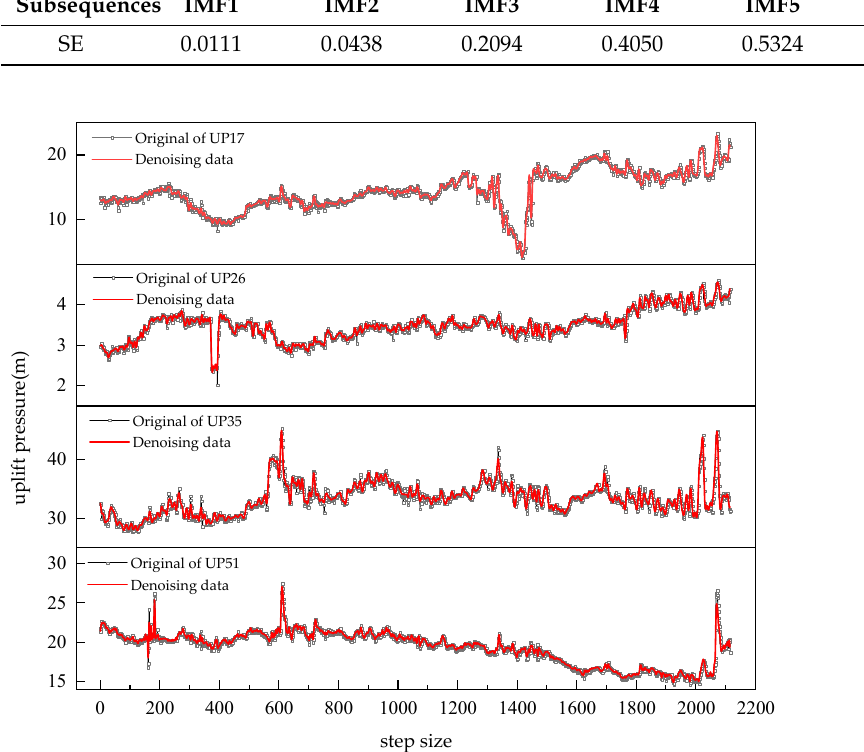
Figure 7. The comparison between the denoised data samples and the original uplift pressure data samples.